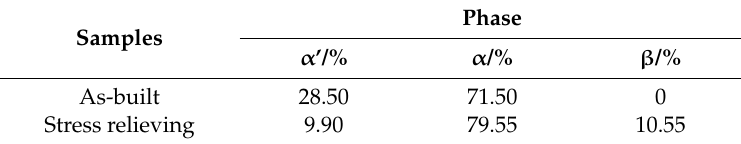
Table 3. The phase composition of as-built and stress relieving